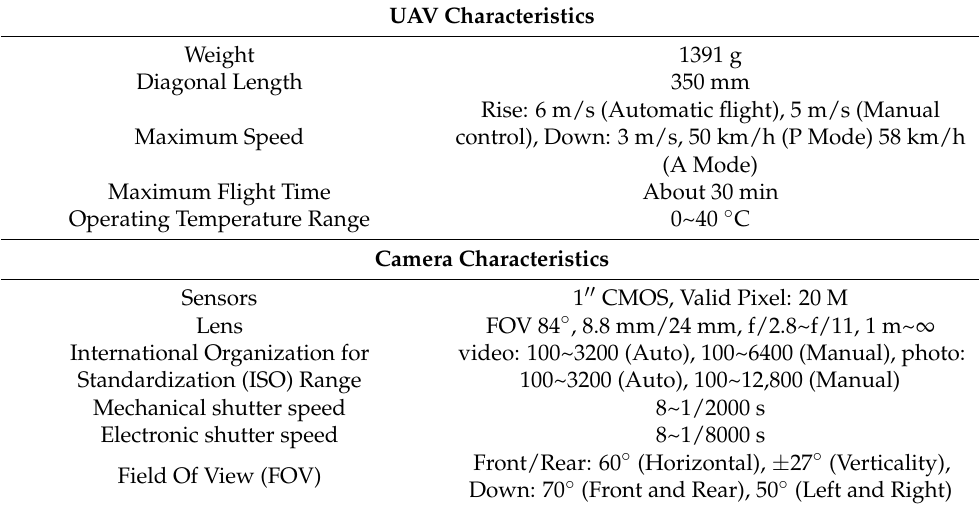
Table 1. Specification of Phantom 4 RTK.